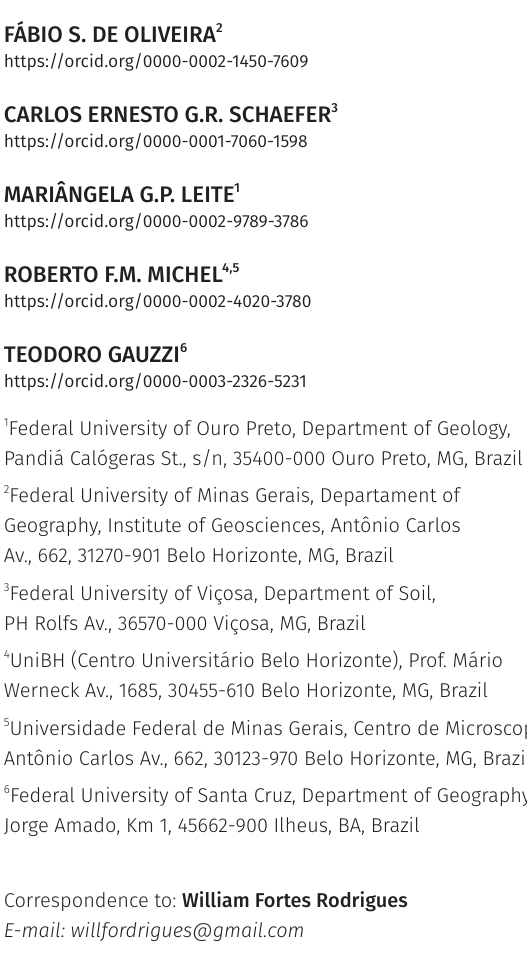
Table SI. PCA loadings of select soil